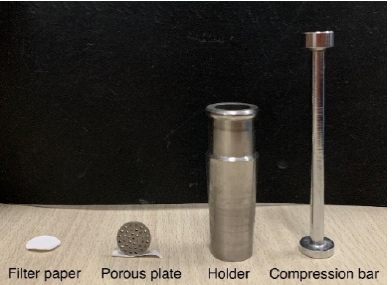
Figure 6. Setup for pressure-filtering of the fresh cement paste to obtain the solution for total organic carbon